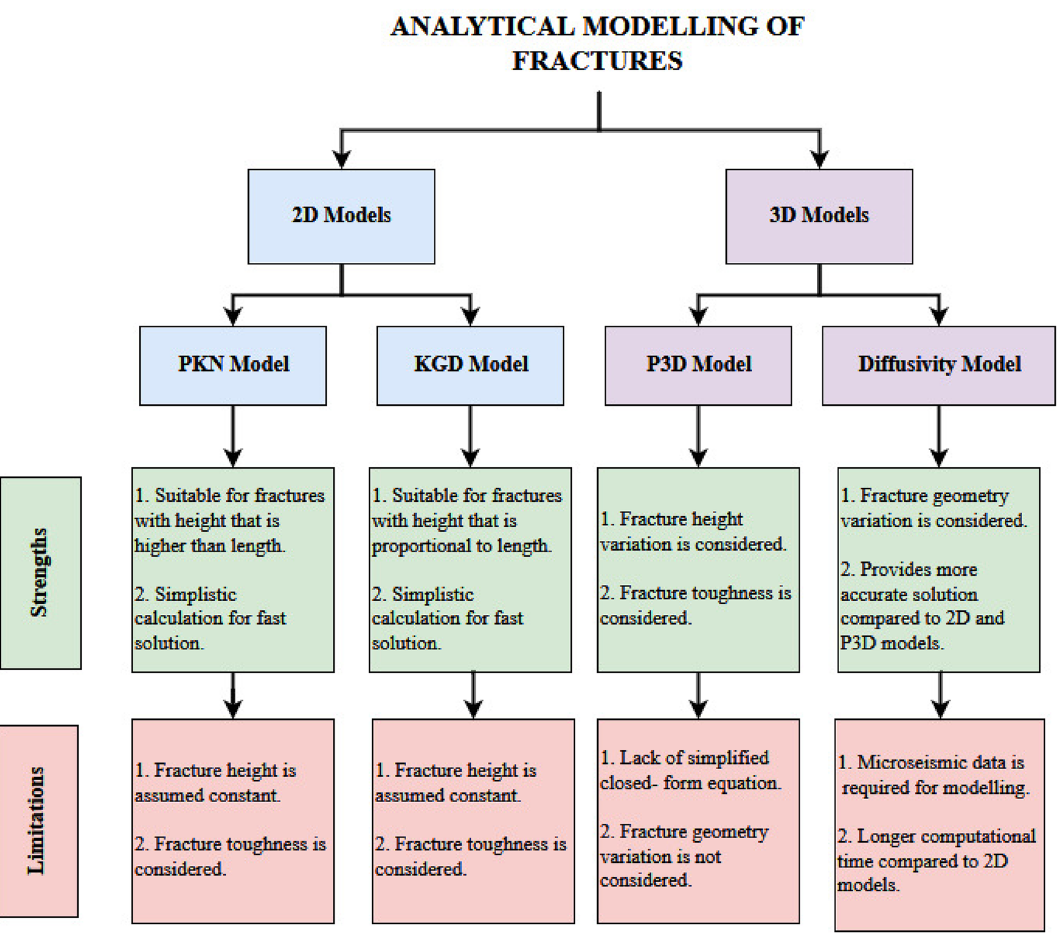
Fig. 1 Comparison of analytical models (Nordgren 1972; Peirce et al. 2010; Perkins and Kern 1961; Settari and Cleary 1984; Simonson et al. 1978; Warpinski and Smith 1989; Yew and Weng 2014; Yousefzadeh et al. 2015; Yu and Aguilera 2012; Zheltov